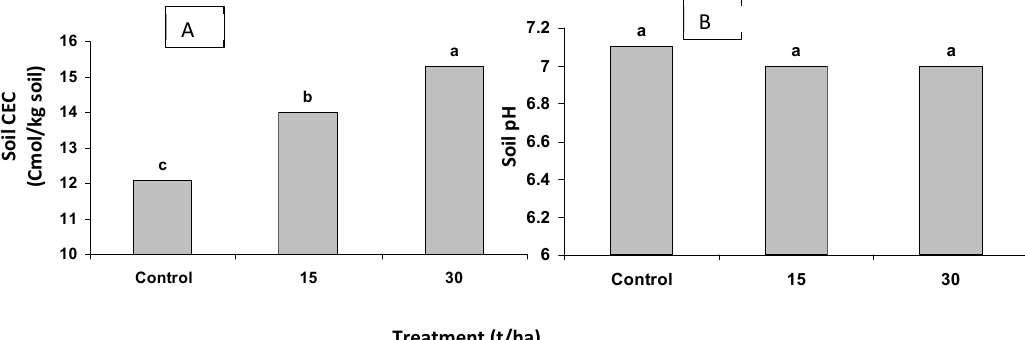
Fig. 1. The simple effect of using sewage sludge on soil CEC (A) and pH (B), the similar letters on the columns in each parameter shows no significant differences (P<0.05) between treatments. Table 3. Effect of foliar application of Nano-Fe oxide, NHAP, and Cd- polluted sewage sludge on plant Cd concentration